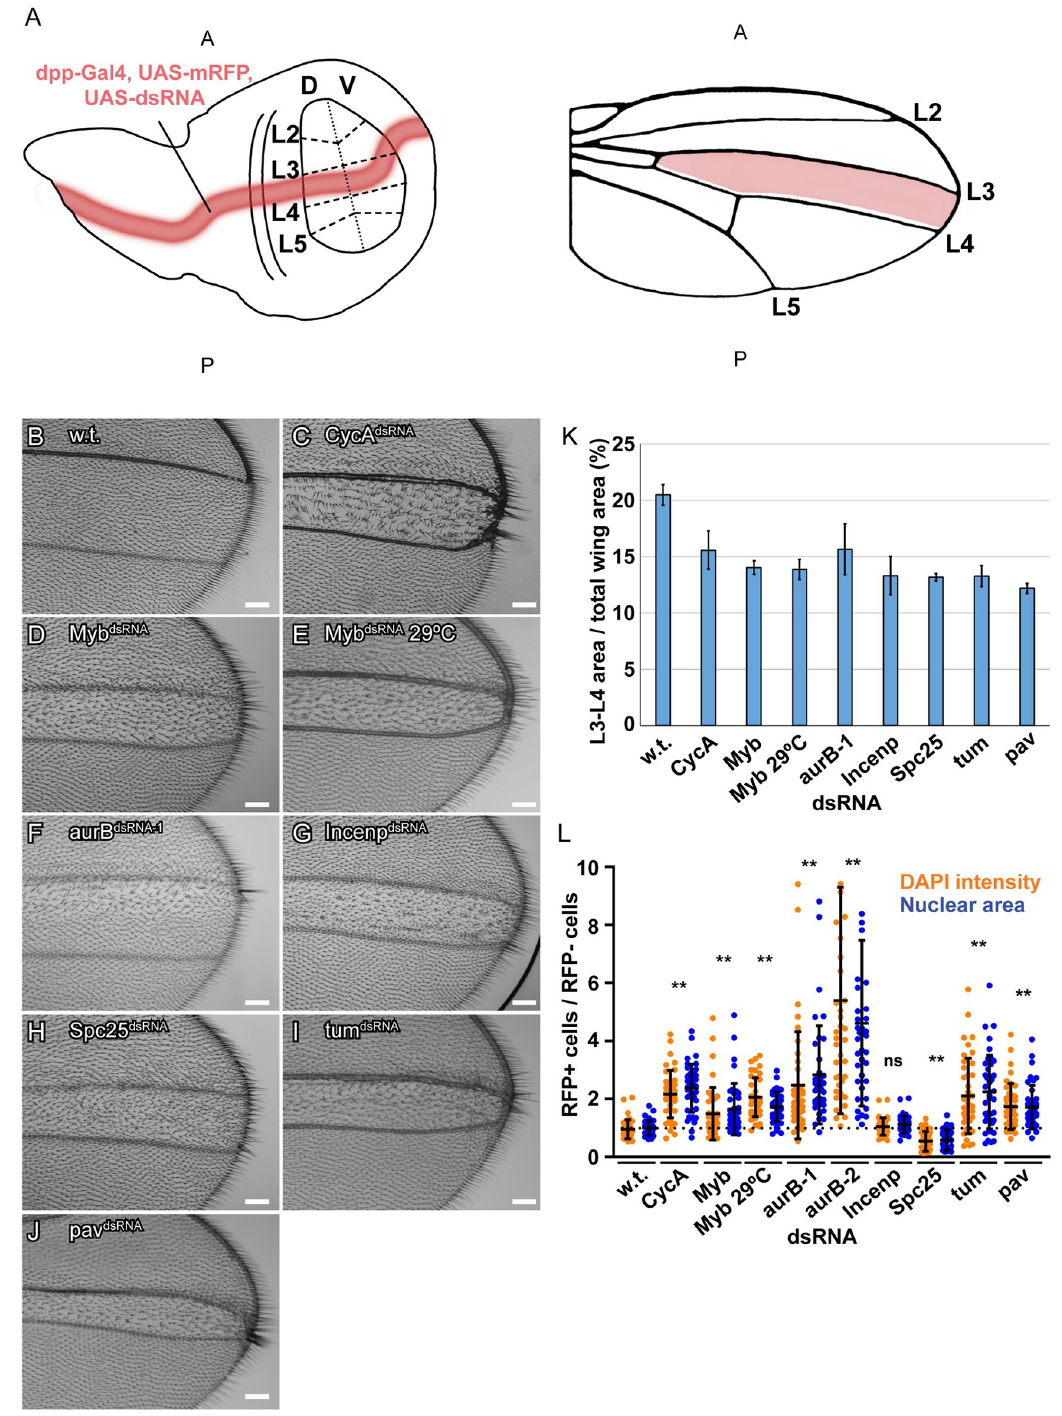
Fig 5. Integration of a genetic screen with RNA-Seq implicates a CycA-Myb-AurB network in endoreplication control. ( A ) Screen strategy: dpp-GAL4 was used to express UAS-mRFP and UAS-dsRNAs along the A-P compartment boundary of wing discs (red stripe in wing disc on left). These cells are fated to form the central part of the adult wing (red stripe in wing on right). This central wing region was screened for larger more widely spaced hairs. ( B-J ) Results from an RNAi screen of candidate genes that were expressed at lower levels in iECs. Shown are brightfield images of an adult wing from animals that expressed dpp-GAL4 and the indicated UAS-dsRNA along the A-P boundary of larval wing discs. (B) A control wild type (w.t.) wing from a dpp : GAL4